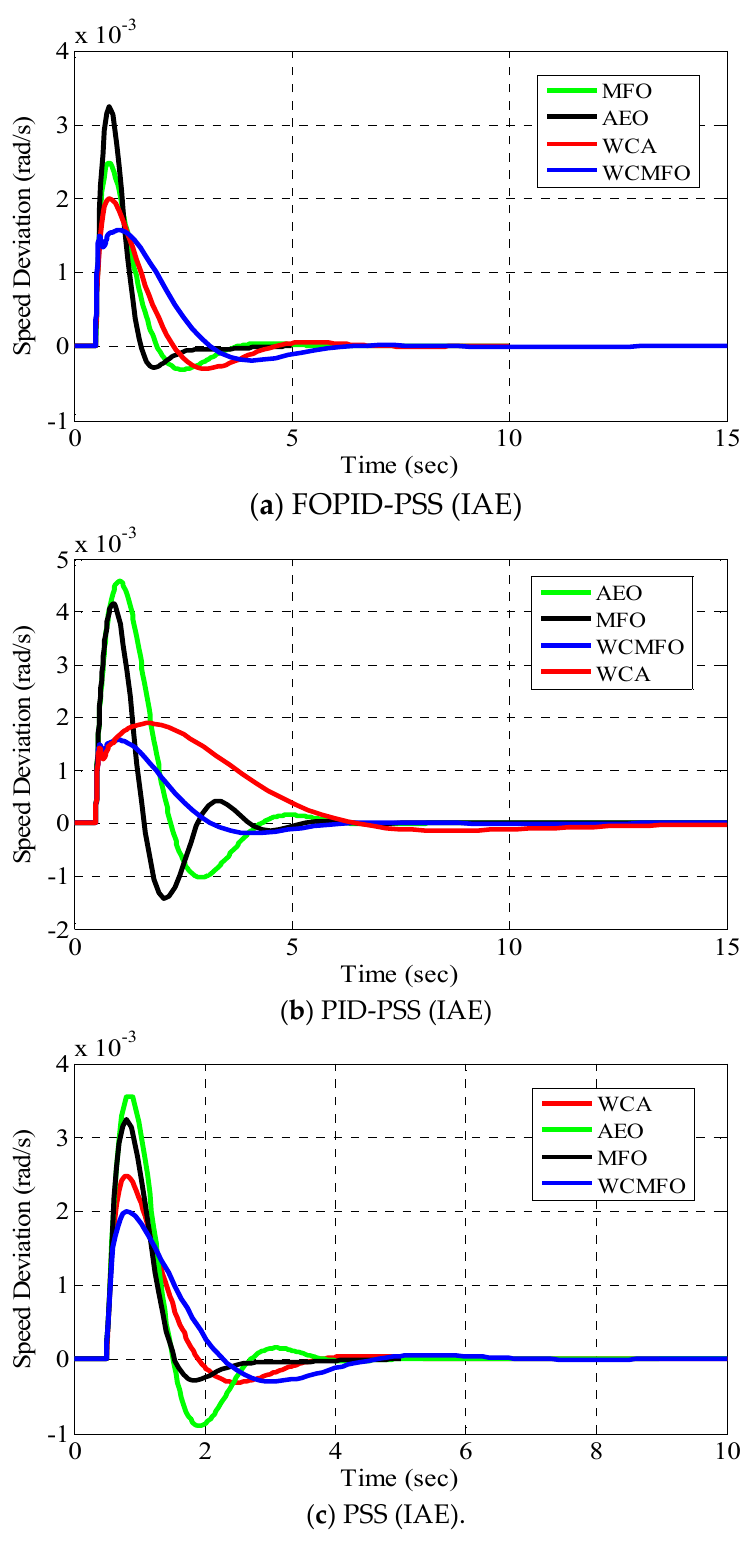
Figure 7. Angular speed deviation ( a – c ).